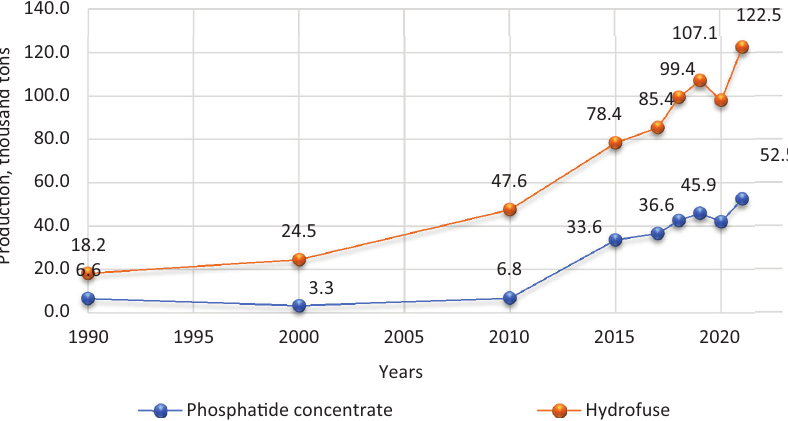
Figure 5. Status and forecast balance of production of hydro processed oil sludge and phosphatide concentrate from sunflower waste in Ukraine, 1990–2021 ( source: based on Lysohor, 2021; AgroChart, 2021; Agroportal, 2022) In the period from 2008 to 2018, exports of sunflower phosphatide concentrate from Ukraine increased almost